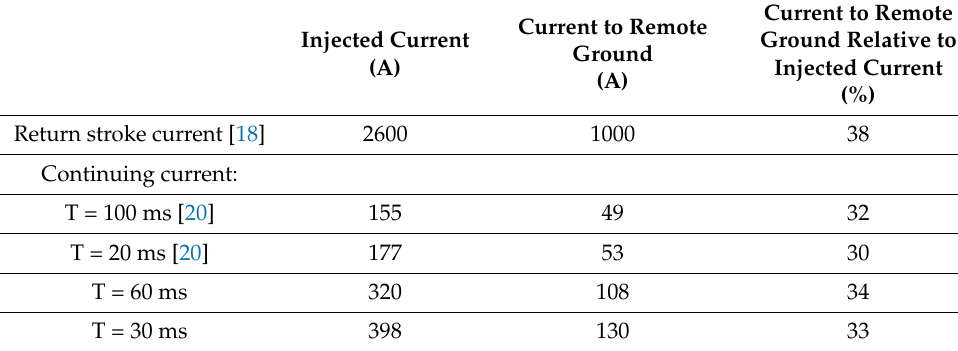
Table 1. A comparison of the efficiency of the LPS for the RS and CC